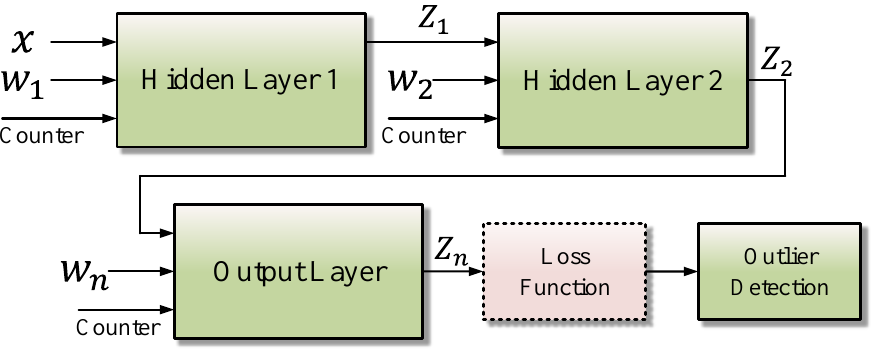
Figure 3. Overview structure of ADNN module.